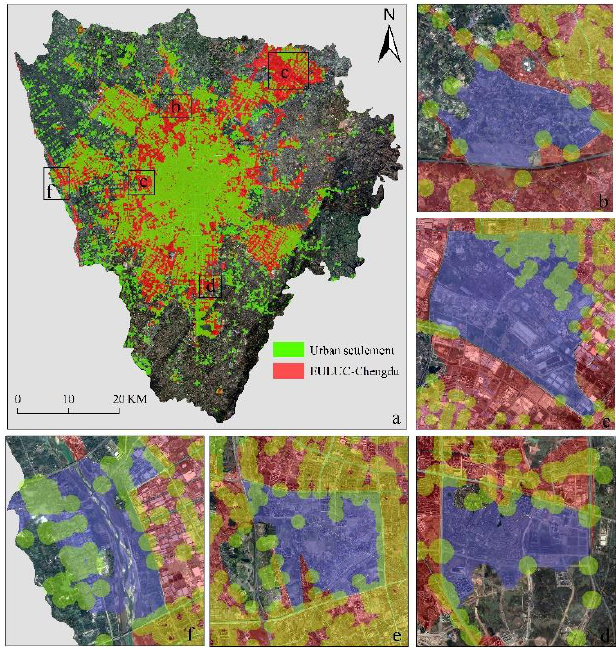
Figure 9. Comparison example for urban territorial scope of Chengdu ( a ). ( b – f ) are part of the Chengdu.